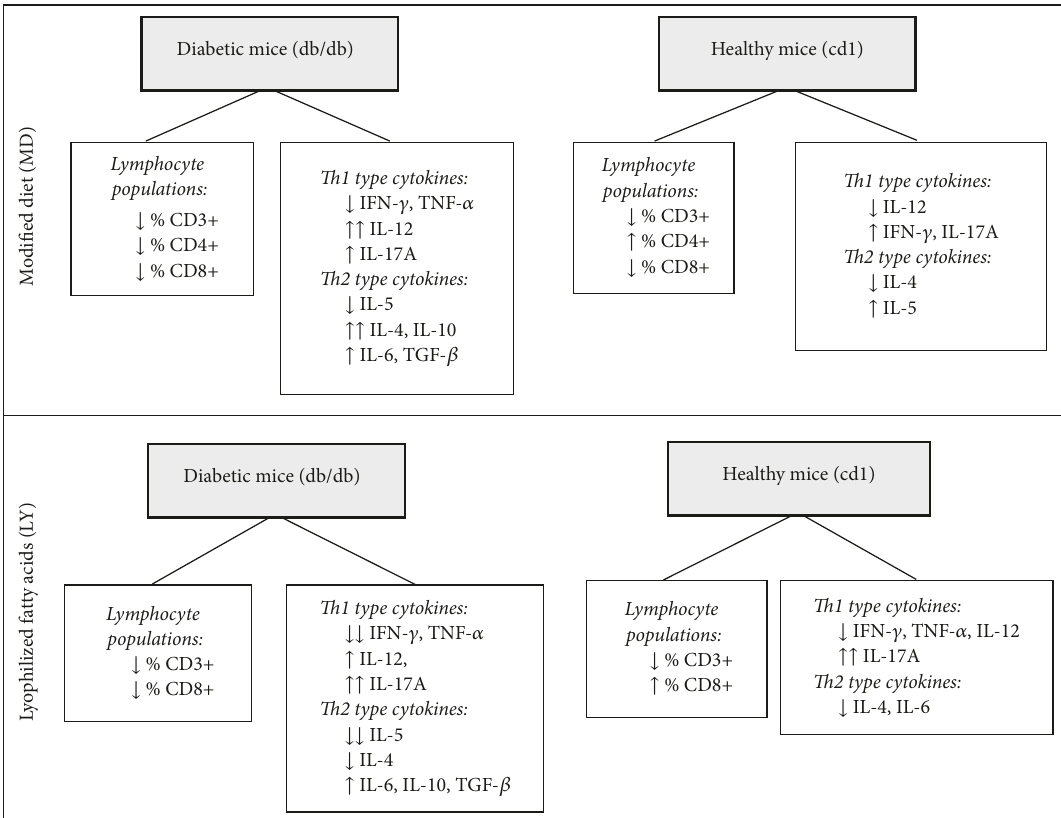
Figure 2: Summary of major findings about microalgae fatty acids supplementation in diabetic and healthy mice.